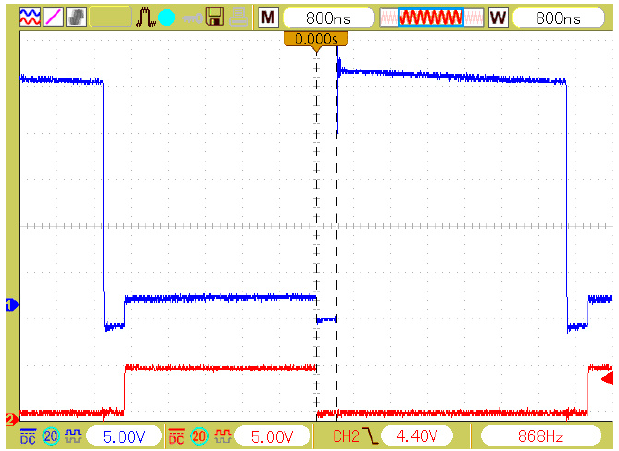
Figure 3. Half-bridge output voltage (blue) and low-side transistor gate signal (red).